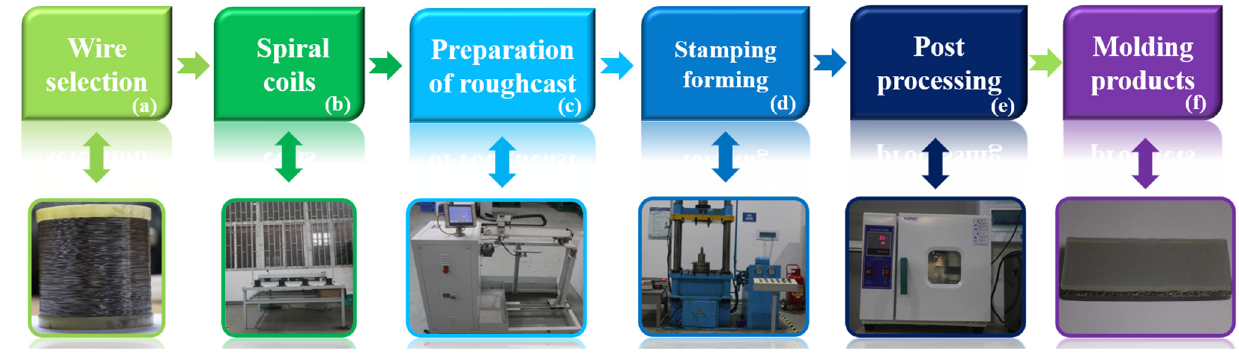
Figure 2. Preparation process of MR.